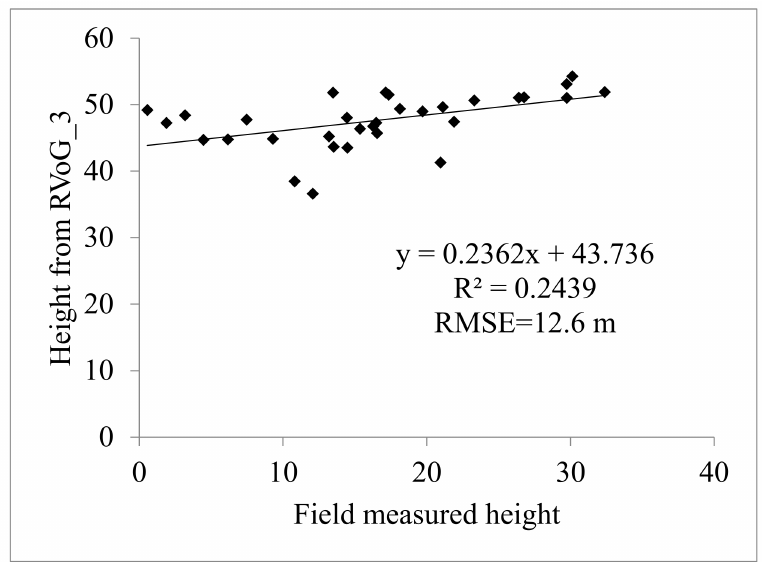
Figure 8. The scatter plot of field forest canopy height and those from RVoG_3 algorithm considering noise decoherence, pre-processing decoherence, baseline distance decoherence and time